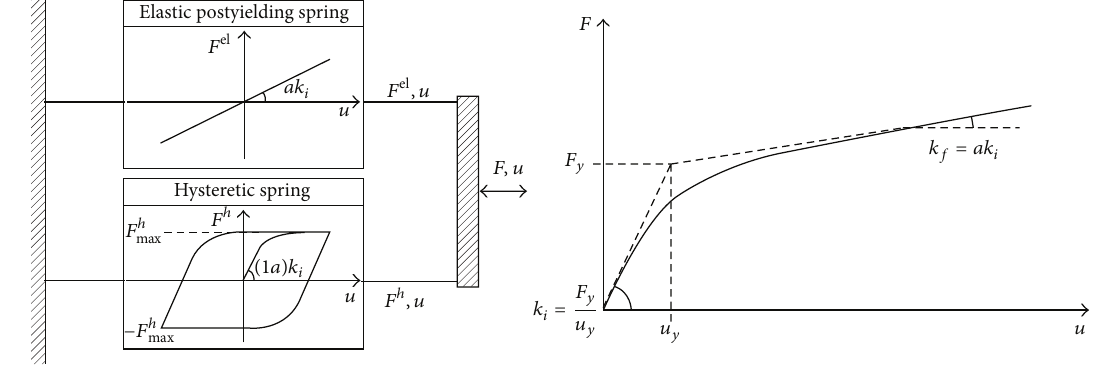
Figure 1: Bouc-Wen model